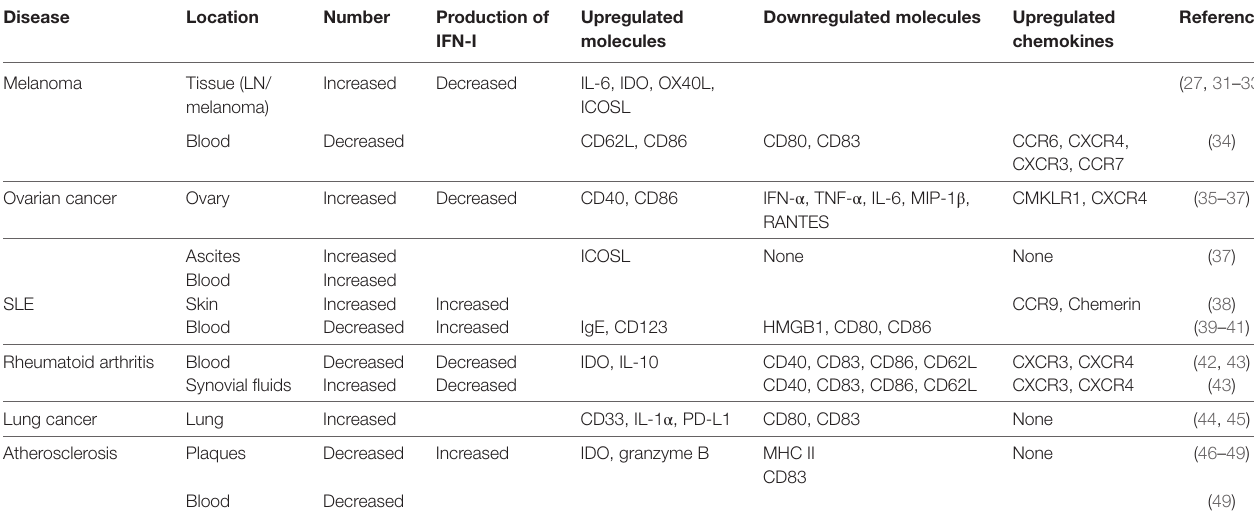
TAble 1 | Changes in pDCs in different diseases.